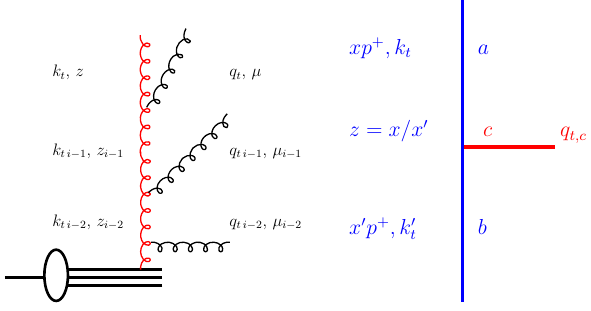
Fig. 3 Left: schematic view of a parton branching process. Right: branching process b → a + c